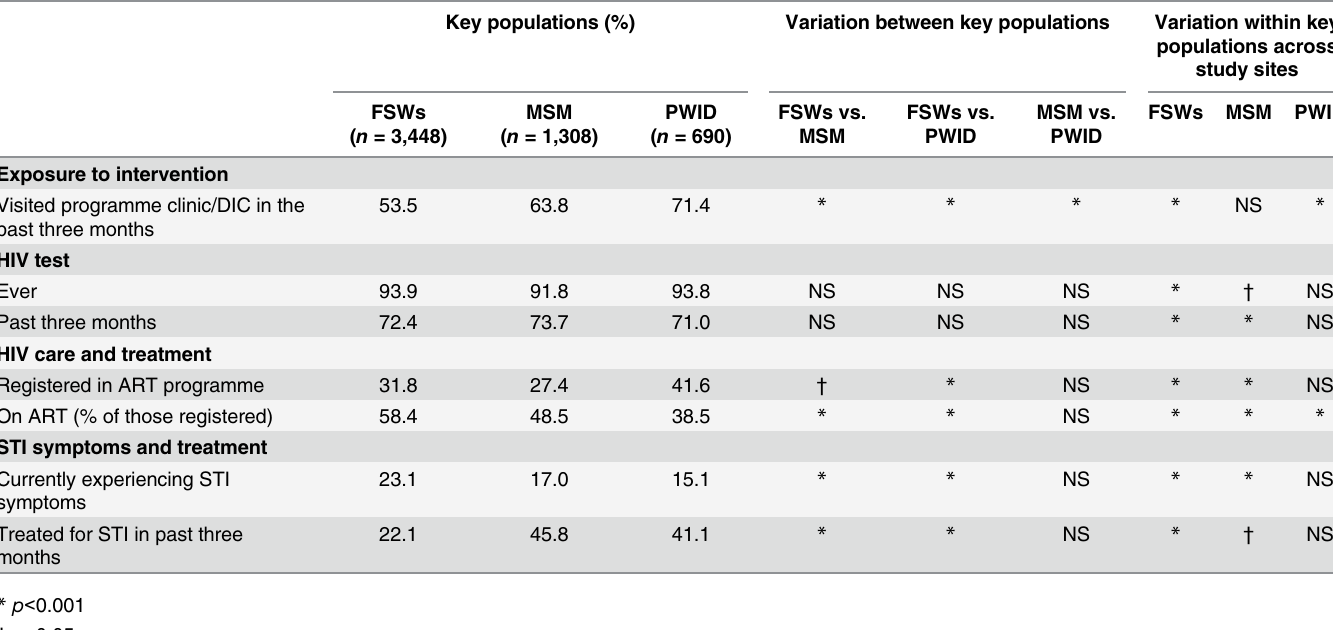
Table 4. Reported exposure to and utilization of biomedical interventions among polling booth survey participants. Key populations (%) Variation between key populations Variation within key